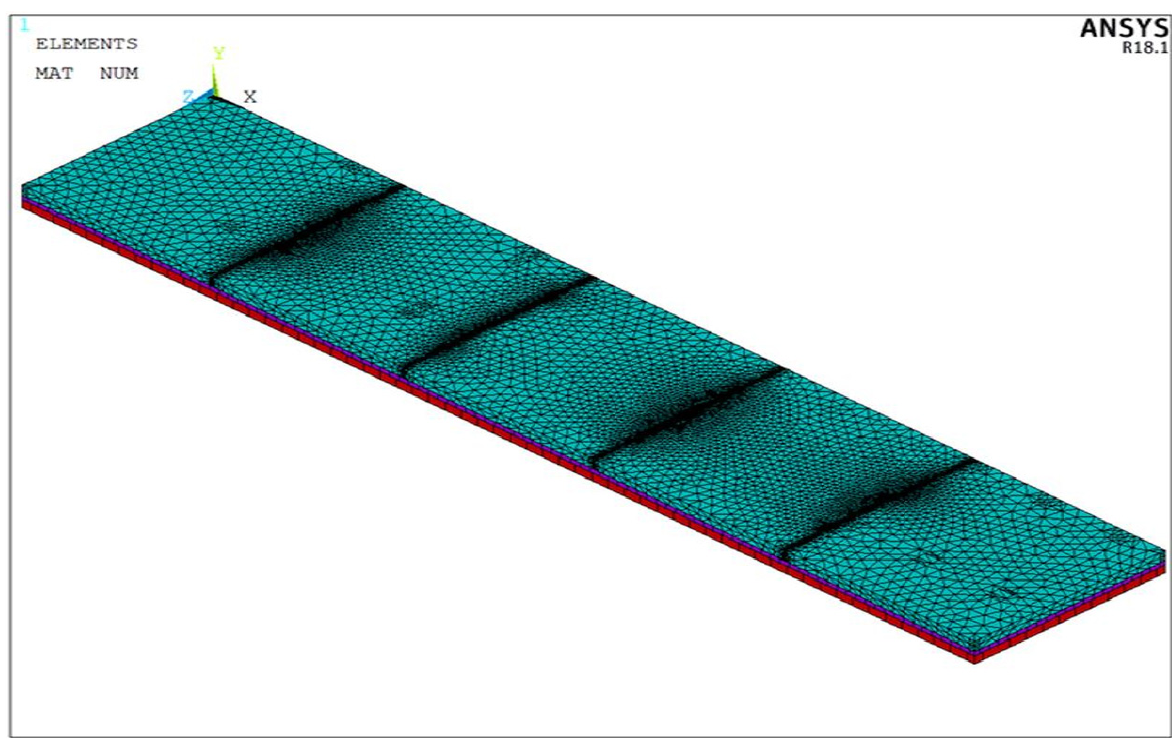
Figure 9. Model mesh image (ANSYS R18.1).